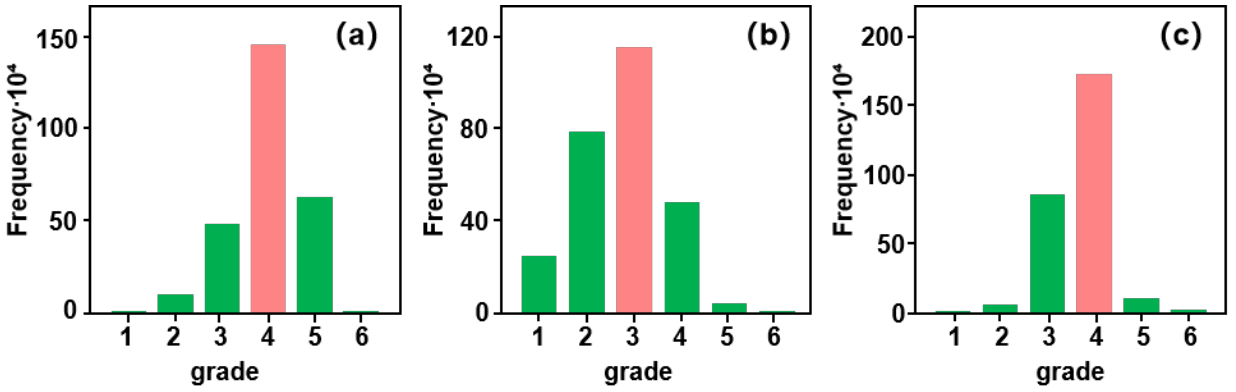
Figure 8. Terrain location calculation results: ( a ) Elevation, ( b ) Slope, ( c ) Topographic potential index. Figure 8. T errain location calculation results: (a) Elevation, (b) Slope, (c) Topographic potential index